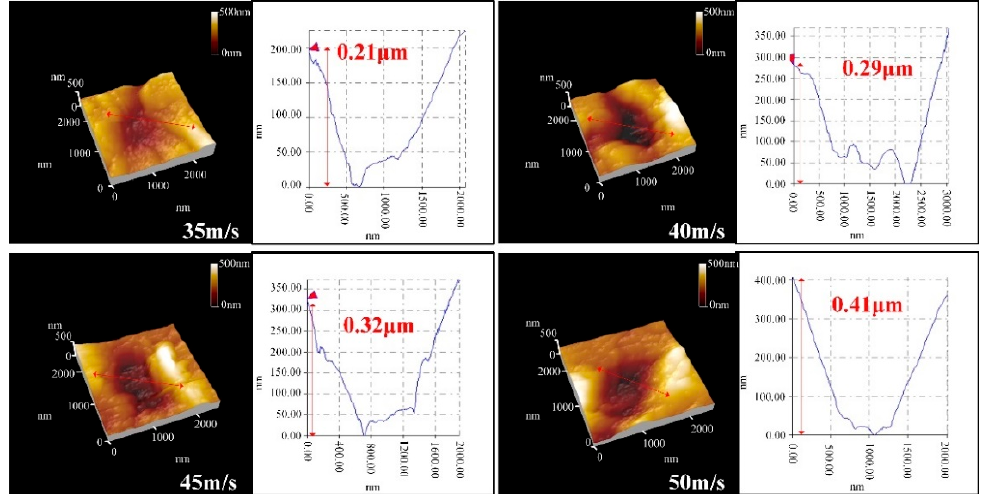
Figure 5. Depth information of a single crater under various impact speeds.